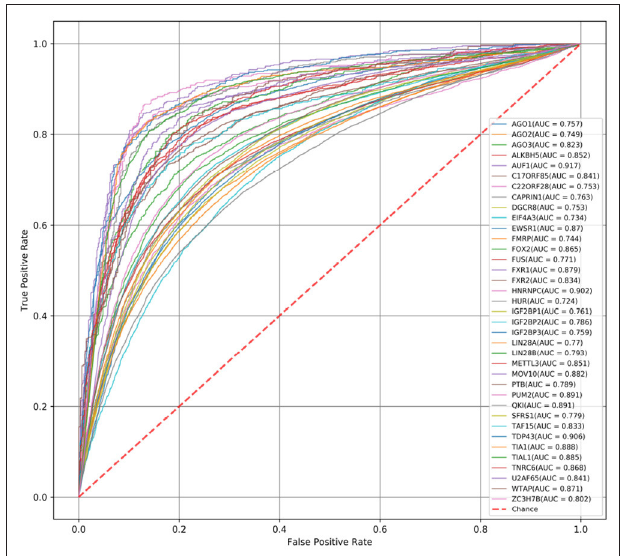
FIGURE 4 | The ROC curves obtained by CRIP for 37 circRNA data sets.